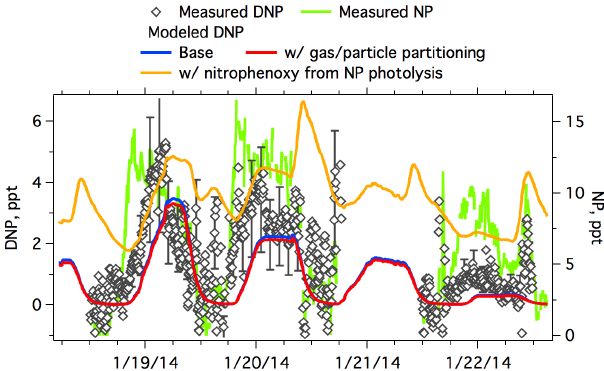
Figure 8. Comparison of measured and modeled time series of DNP. Measured time series of NP is also shown for comparison. Error bars indicate the accuracies of measured DNP concentrations